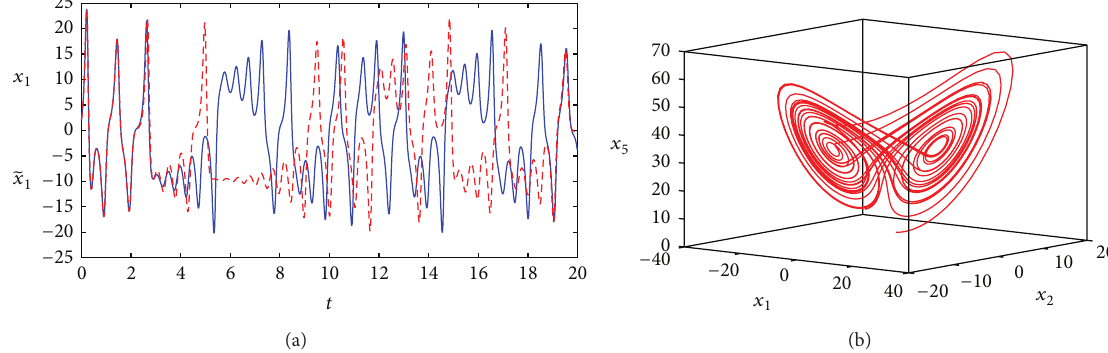
(0) = 2.001 ; ̃𝑥 (0) = 1 ; ̃𝑥 (0) = 5 ; ̃𝑥 (0) = 3 ; ̃𝑥 (0) = 4.01 (the dotted curve) ( 𝑡 = 𝑡𝑖𝑚𝑒/10 ). Right figure: 1 2 3 4 5